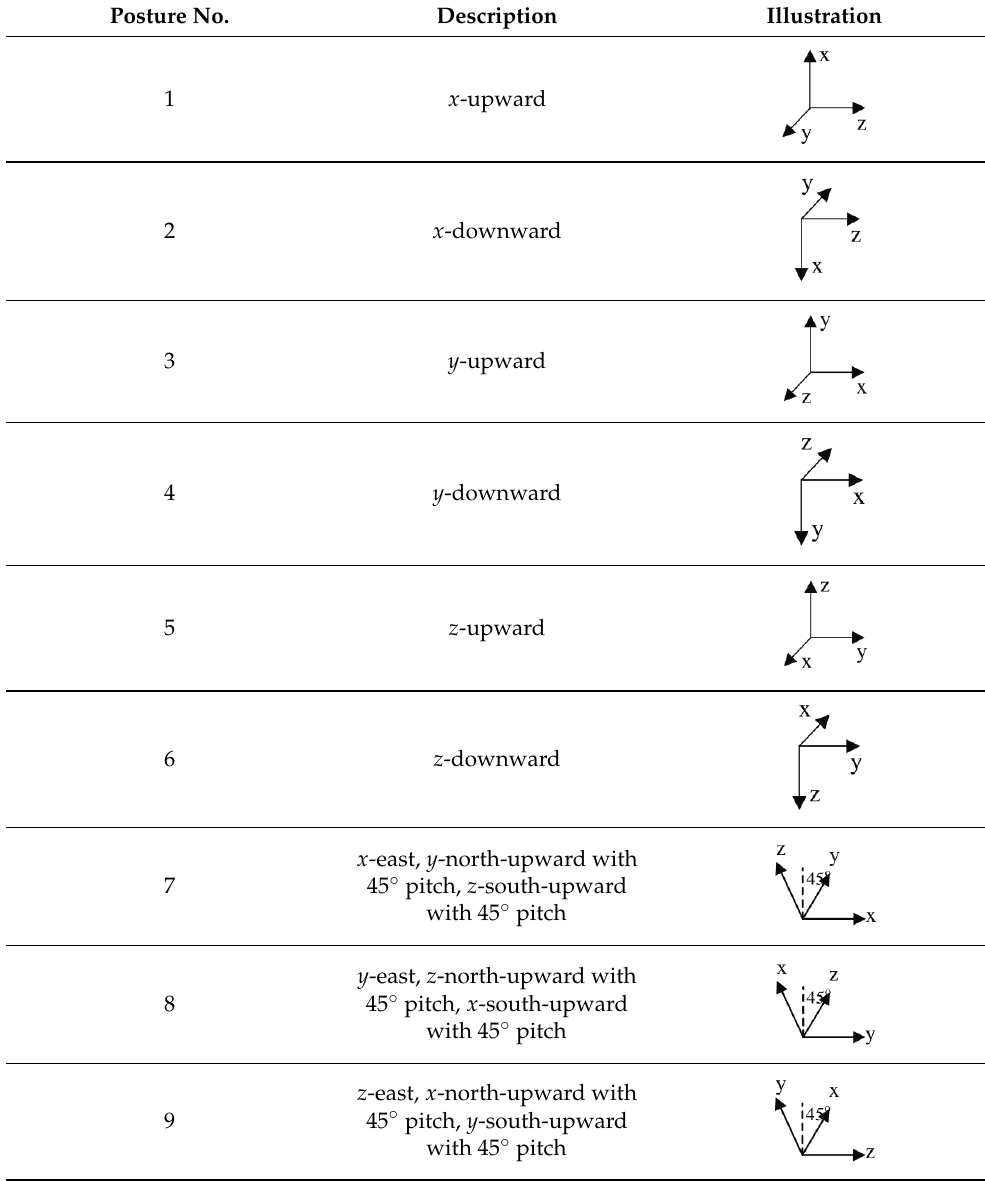
Table 3. Approximately optimal nine attitudes for calibrating accelerometers [76]. Posture